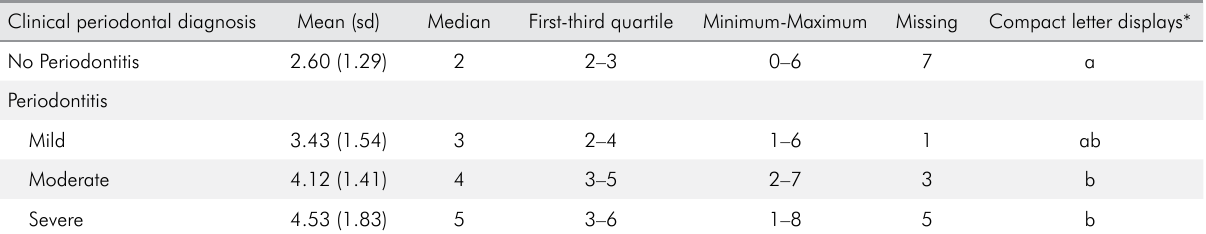
Table 3. Concurrent validity of the OHQB-Br with the periodontal clinical diagnosis (n =